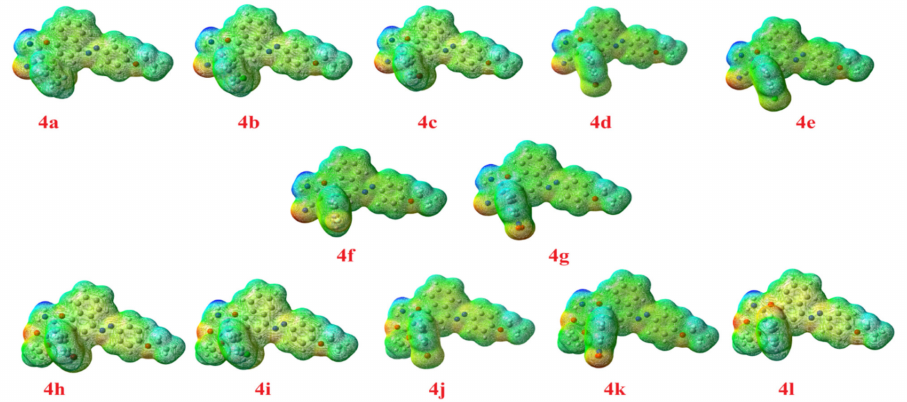
Figure 11. The molecular electrostatic potential for the prepared compounds ( 4a-l ), blue color indicates hydrophobic regions and red color denotes hydrophilic polar